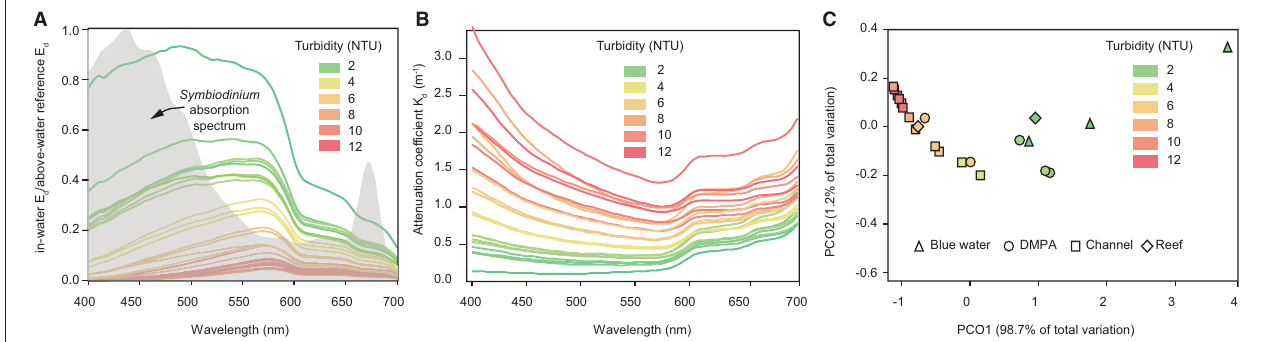
FIGURE 5 | Vertical profiling study. (A) normalised (in-water E d divided by above-water reference E d ) downwelling irradiance spectral profiles, (B) spectral attenuation coefficients at 3m depth for 23 vertical light profiles with NTU values at 3m depth ranging from 1 to 11.1 NTU. The grey shaded area in (A) represents the absorption spectra of isolated symbiotic dinoflagellates (of corals) digitised from Figure 2 b in Hennige et al. (2009). (C) Principal coordinate analysis (PCO) of spectral profiles for the same vertical profiles. Where triangles represent “blue water” profiles sampled beyond the 15m depth contour outside Cleveland Bay ( n = 3), “DMPA” represents samples collected in the dredge material placement area ( n = 5), “channel” represent samples collected in the Platypus channel or < 50m either side of the channel, and Reef represents samples off the reef slope near Geoffrey Bay ( n = 3) (see Figure 1 ).